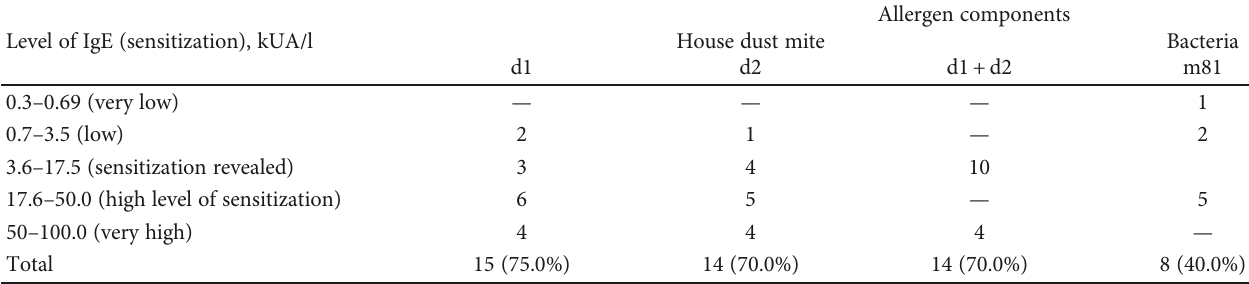
Table 4: The distribution of patients with PAR in terms of the level of sensitization to allergen components of house dust mites and bacterial micro fl ora ( N = 20